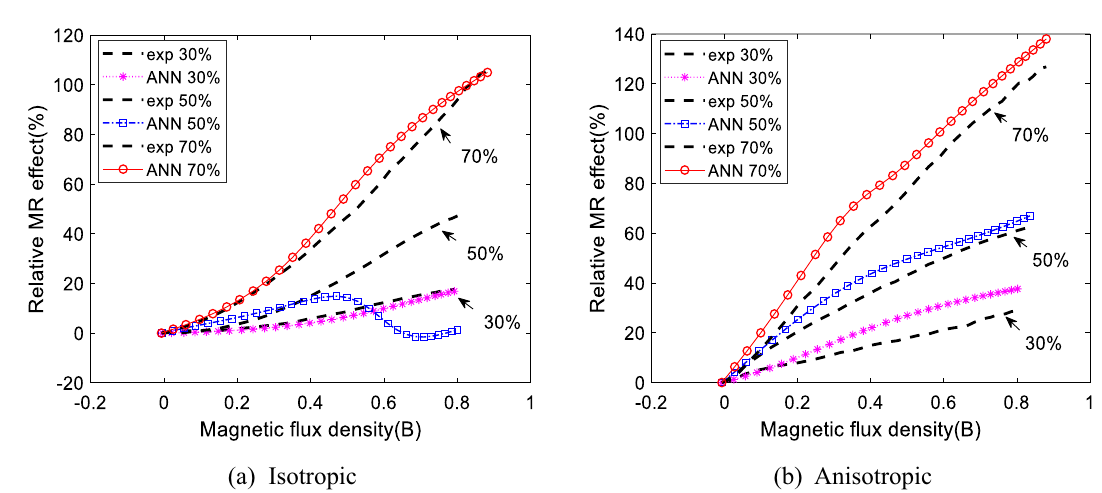
Figure 12. The comparison of relative MR effect between experimental and ANN model.